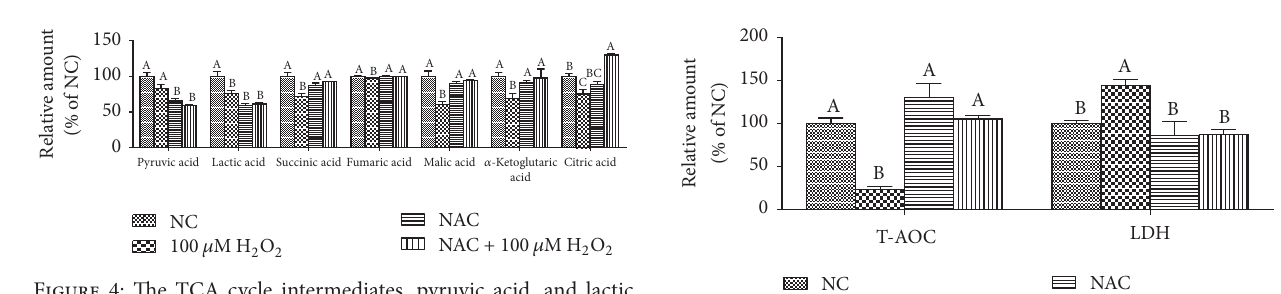
Figure 4: The TCA cycle intermediates, pyruvic acid, and lactic acid of IPEC-J2 cells measured by an Agilent 7890B-5977A GC- MS equipped with HP-5ms (30m × 250 𝜇 m × 0.25 𝜇 m) capillary column (Agilent J&W, Santa Clara, CA, USA). Cells were treated with 0 (NC) or 800 𝜇 M NAC and 0 or 100 𝜇 M H 2 O 2 , respectively. Data were expressed as means ± SEM of at least three independent experiments. a–c Values with different letters are significantly differ- ent ( 𝑃 < 0.05 ).